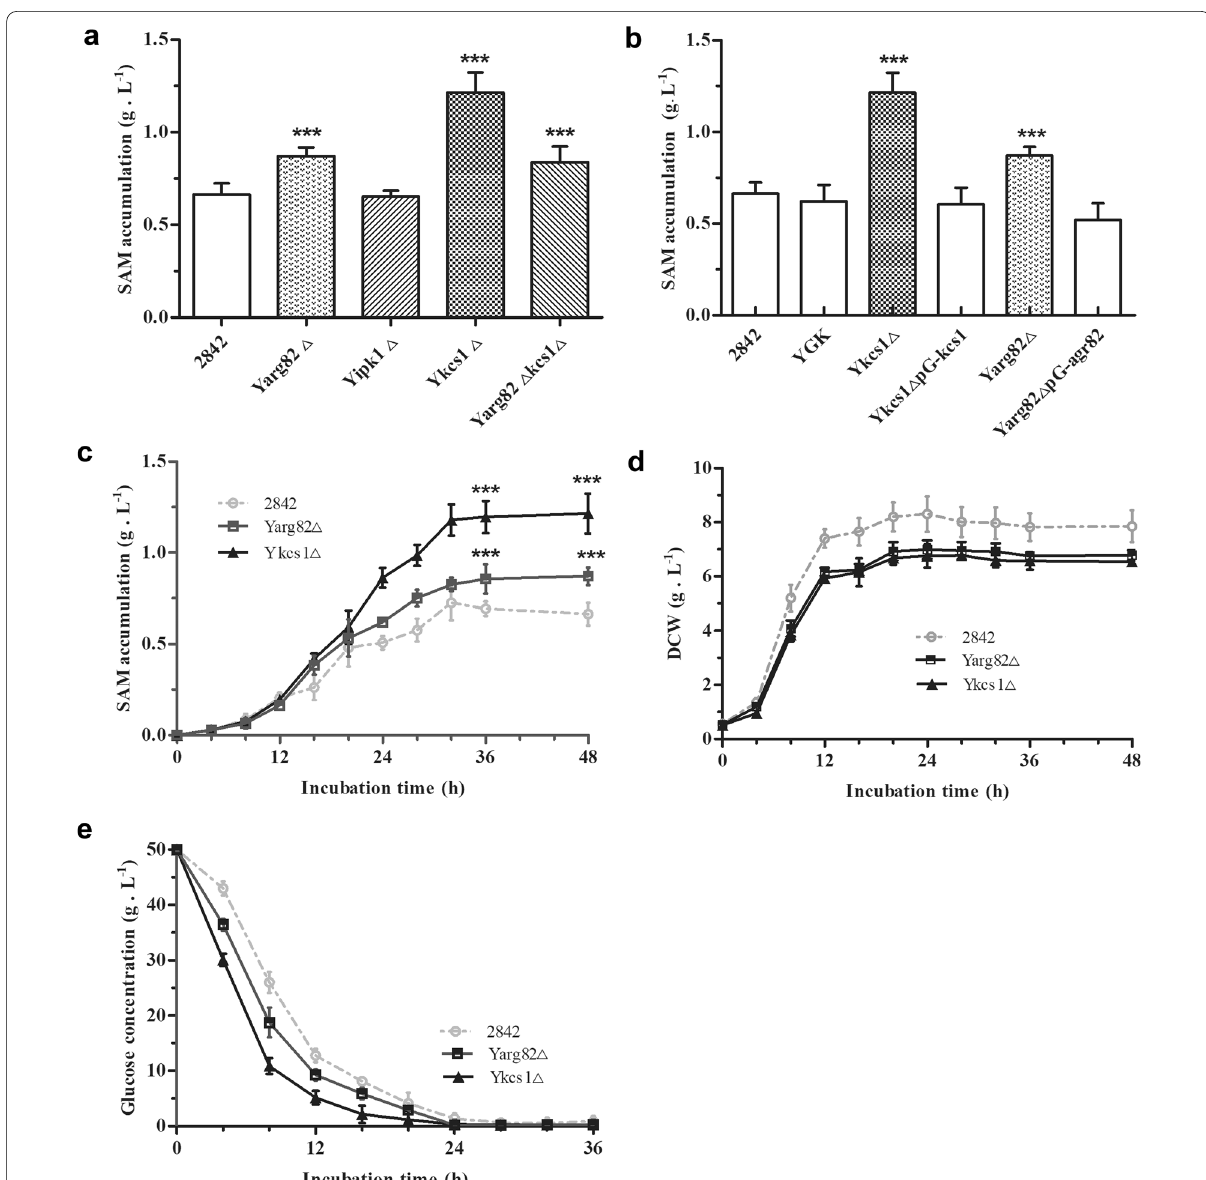
Fig. 2 Deletion of kcs1 and arg82 improved SAM production and increased the glucose uptake rate in Saccharomyces cerevisiae . a The SAM accumulations of the strains deleted the several genes in metabolism of IPs; b The SAM accumulations of the strains reintroduced of kcs1 and arg82 ; c The accumulation curve of SAM of the kcs1 or arg82 deletion strains; d The glucose consumption curves of kcs1 or arg82 deletion strains; e The growth curve of the kcs1 or arg82 deletion strains. Error bars correspond to standard error of mean (SEM) of the biological replicates (n denotes significant differences between the recombinant strain and the wild strain, with p < 0.001